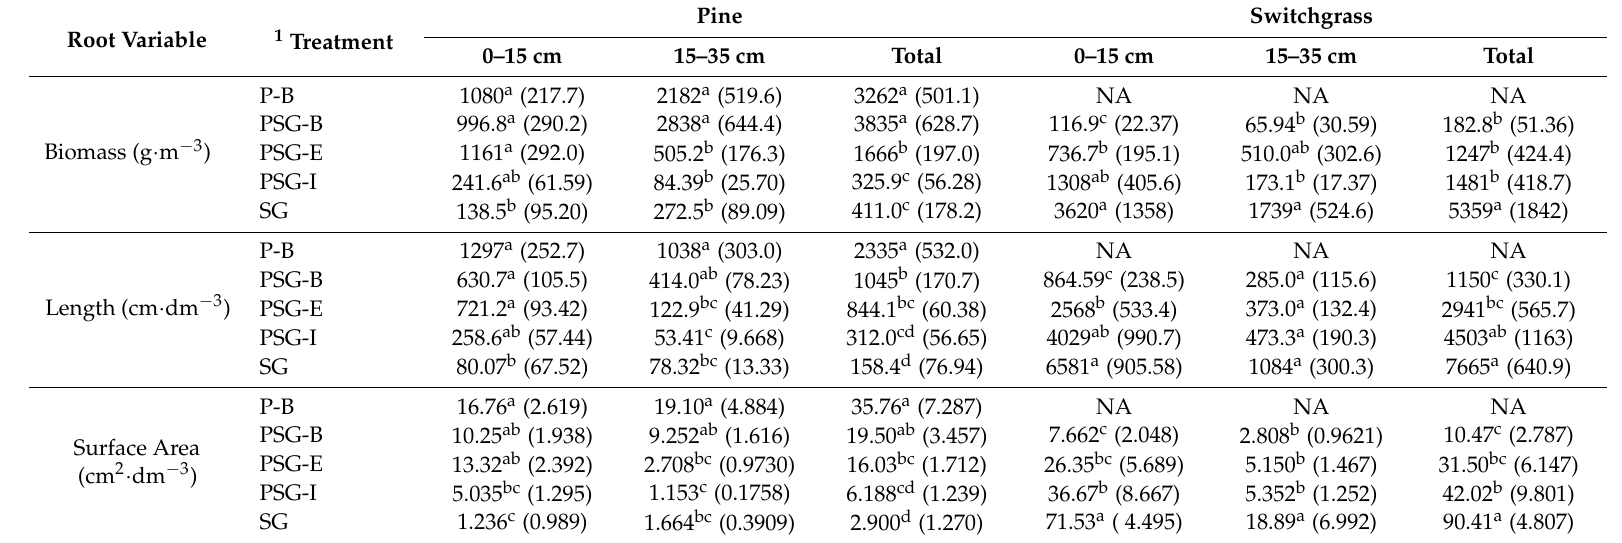
Table 3. July switchgrass and loblolly pine root biomass (g · m − 3 ), average root length (cm · dm − 3 ), and average root surface area (cm 2 · dm − 3 ) in the fresh cores